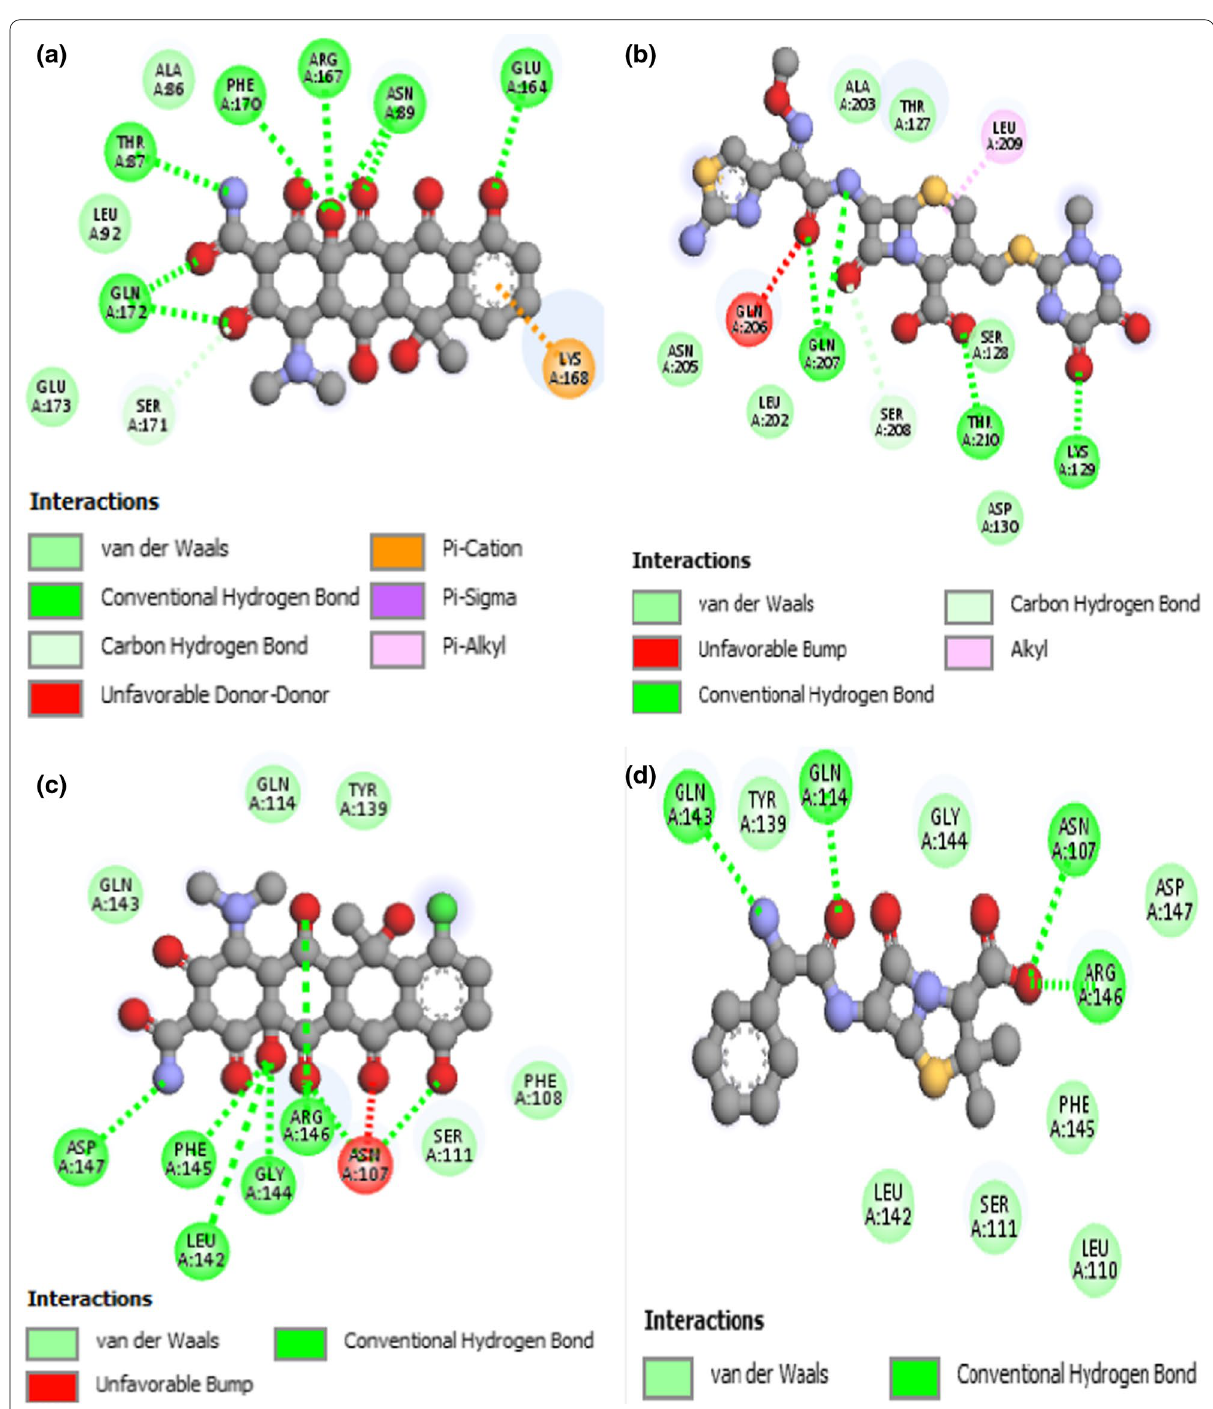
Fig. 1 Interactions of the reference drugs: ( A ) ampicillin, ( B ) oxytetracycline, ( C ) chlortetracycline, and ( D ) ceftriaxone with the crystal structure of IncA soluble